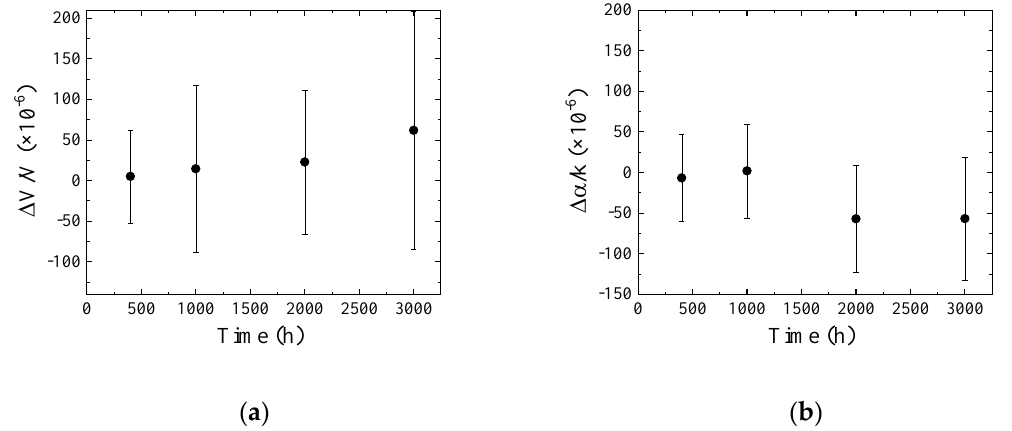
Figure 10. Evaluation of the SH-SAW sensor responses in Figure 9. The solid line shows the Newtonian fluid.